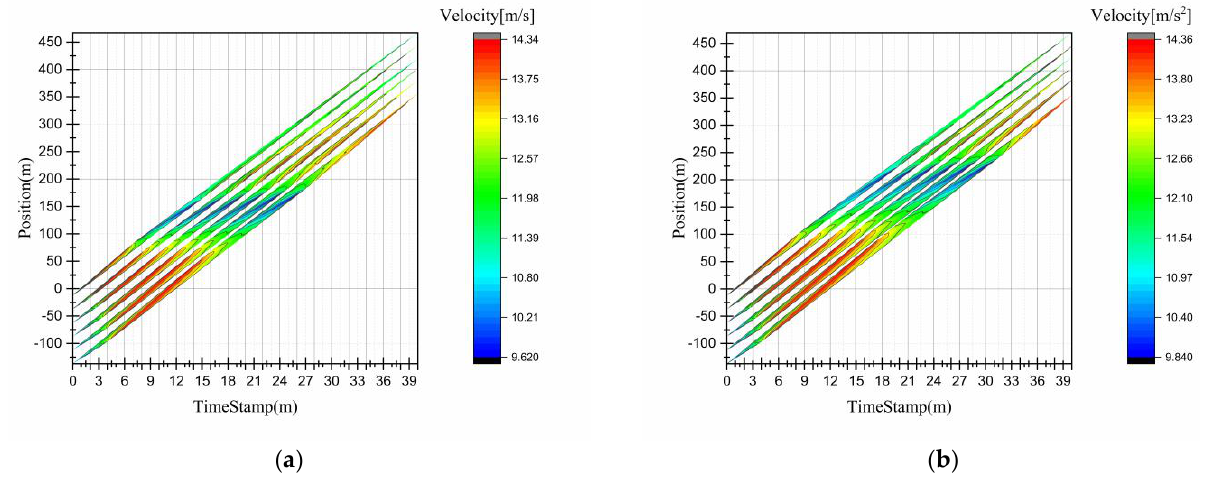
( b ) Figure 19. Acceleration heatmaps of CAVF fleet and CACCNF fleet under scenario 4: ( a ) CAVF acceleration heatmap; ( b ) CACCNF acceleration heatmap. As shown in Table 8, the average CACCNF team jerk is 88% and the average CAVF team jerk is 74.5%, representing a 13.5% increase in comfort. Table 8. Comfort degree of CAVF fleet and CACCNF fleet. Queue Train Number Queue Type